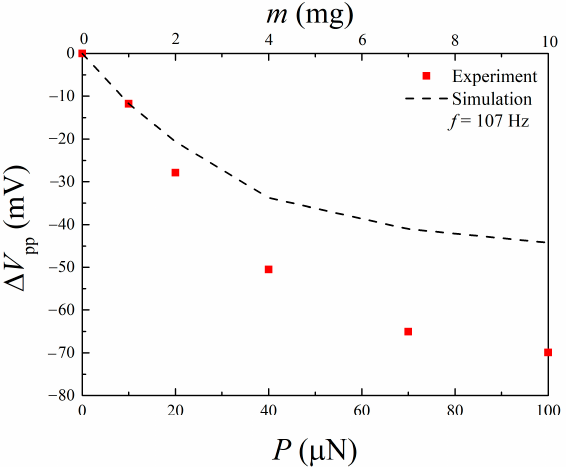
Figure 7. Measured and calculated output voltage change versus load or weight.